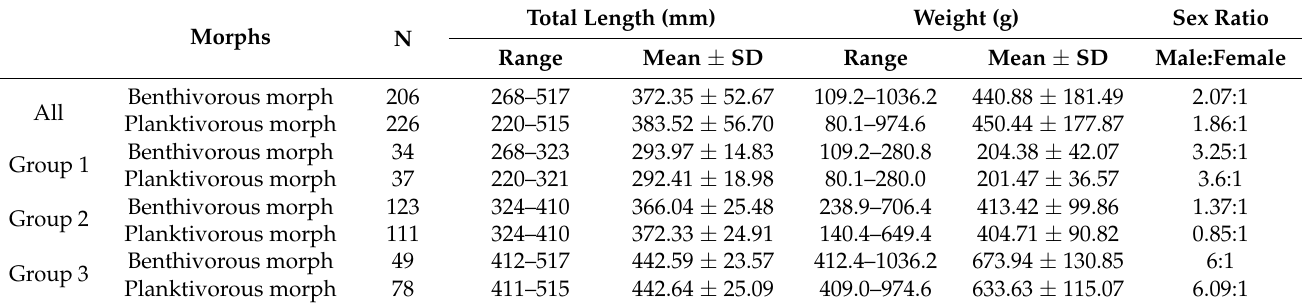
Figure 1. Schizopygopsis thermalis sampling locations (black dots) in Lake Amdo Tsonak Co. Blue arrows represent the direction of the stream. Table 1. Summary of basic information of two morphs of Schizopygopsis thermalis collected in 2017 and 2018, including total length (TL) and weight with standard deviation (SD), TL groups and sex ratio.